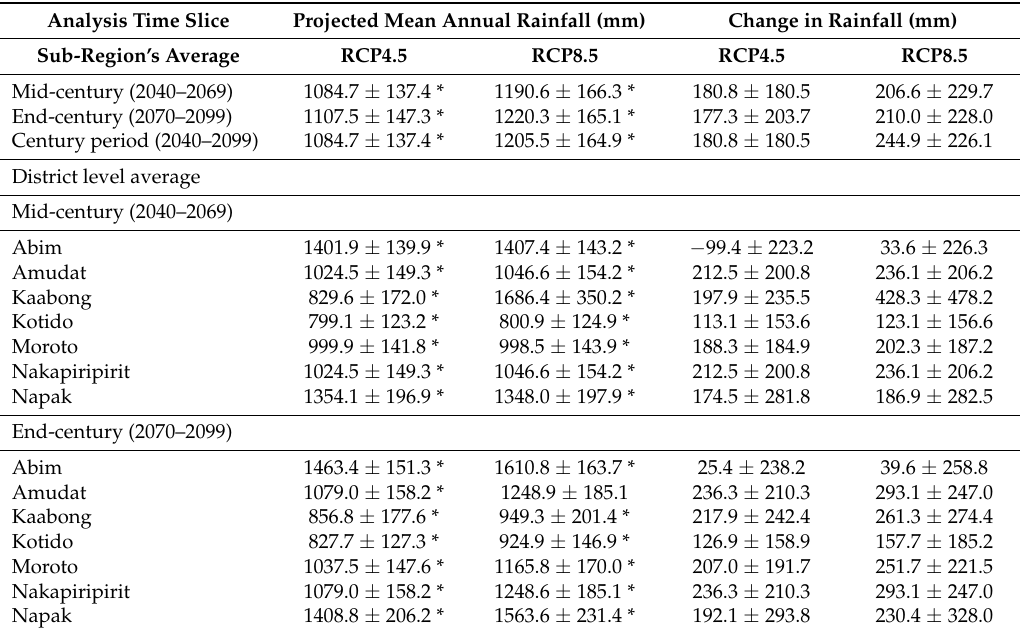
Table 4. Projected rainfall in Karamoja sub-region.